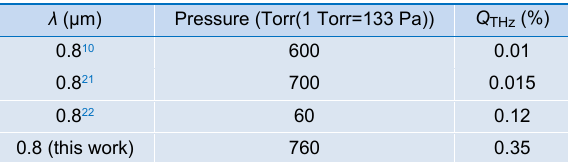
Table 1 | Energy conversion efficiency Q THz of THz pulse gener- ated by the two-color field (800 nm + 400 nm) filamentation in ar- gon gas.